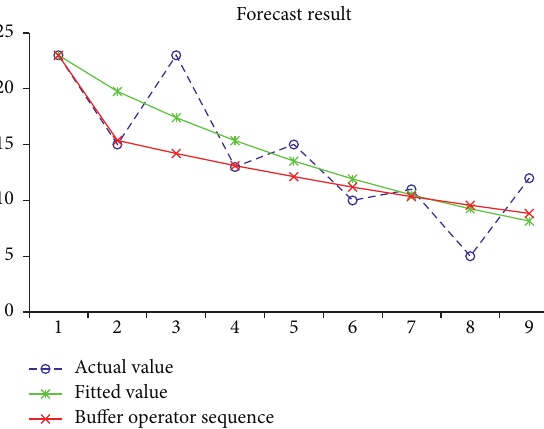
Figure 5: The GM (1, 1) fitted value of original sequence and buffer operator